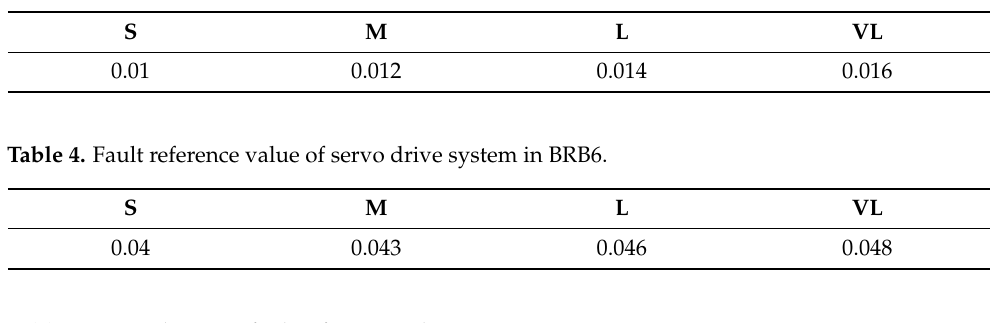
Table 5. Control system fault reference value in BRB6.